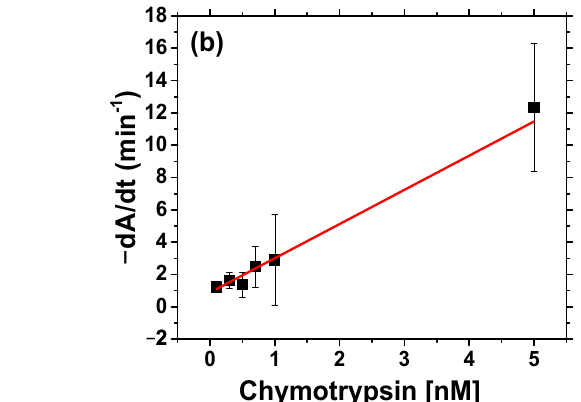
Figure 6. ( a ) Calibration curve for chymotrypsin fitted by reverse Michaelis—Menten model. dA/dt is numerical deriva- tion of linear model of absorbance change at time t = 0 and corresponds to the rate of enzyme reaction. ( b ) Linear part of calibration curve − dA/dt vs. concentration of chymotrypsin for calculation of limit of detection (LOD). − dA/dt = (6.30 ± 0.23) × 10 − 4 min − 1 nM − 1 + (1.9 ± 0.4) × 10 − 4 min − 1 . (R 2 = 0.993), LOD = 0.15 ± 0.01 nM.